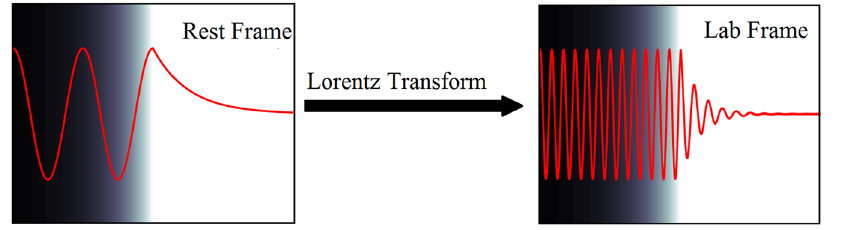
Figure 2. A simple schematic of how transforming from the rest frame of the expanding plasma into the laboratory frame leads to a continued propagation of the vector potential wave (red) beyond the plasma’s critical surface - indicated by the boundary between dark (vacuum) and white